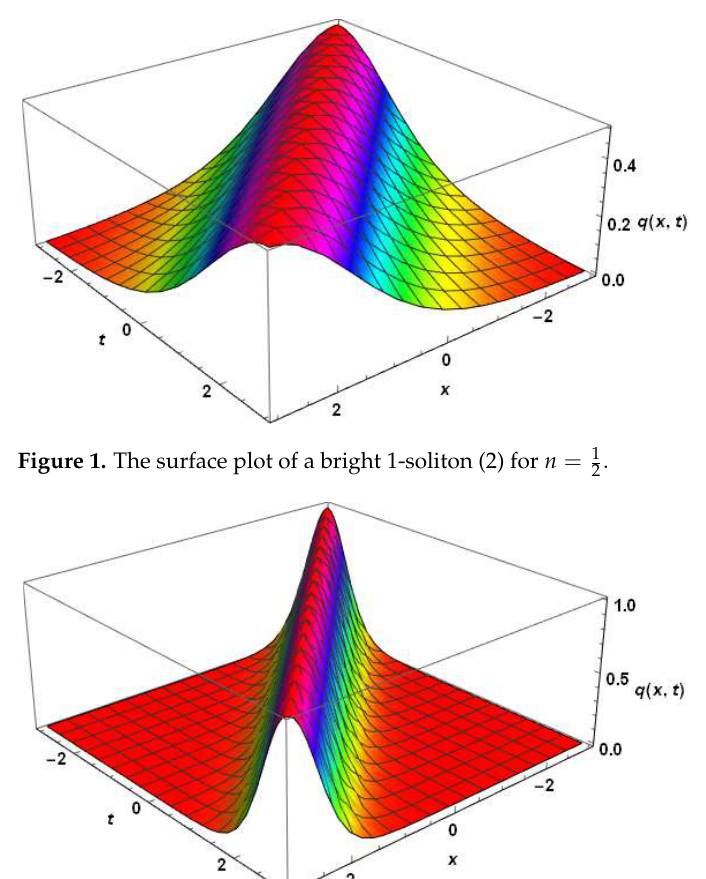
Figure 2. The surface plot of a bright 1-soliton (2) for 𝑛 =